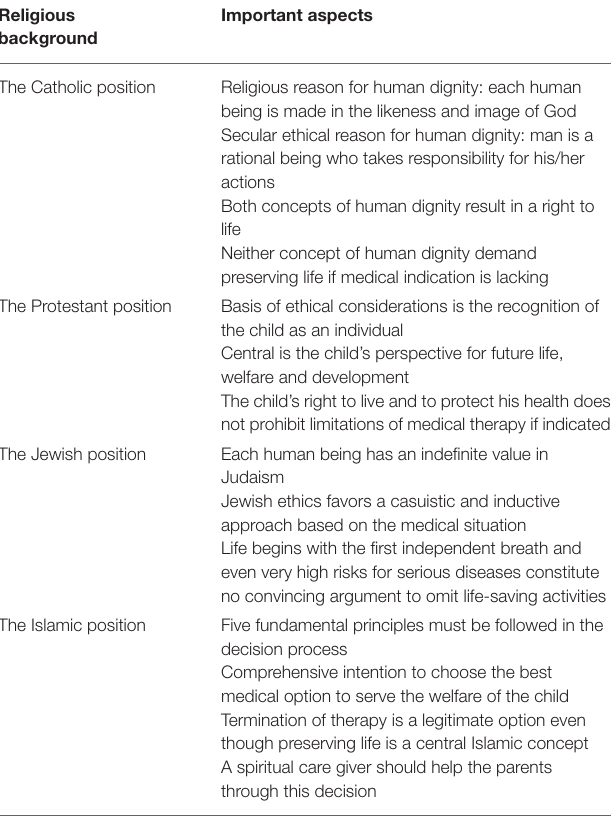
TABLE 1 | Impact of the religious background on the process of decision making. Religious